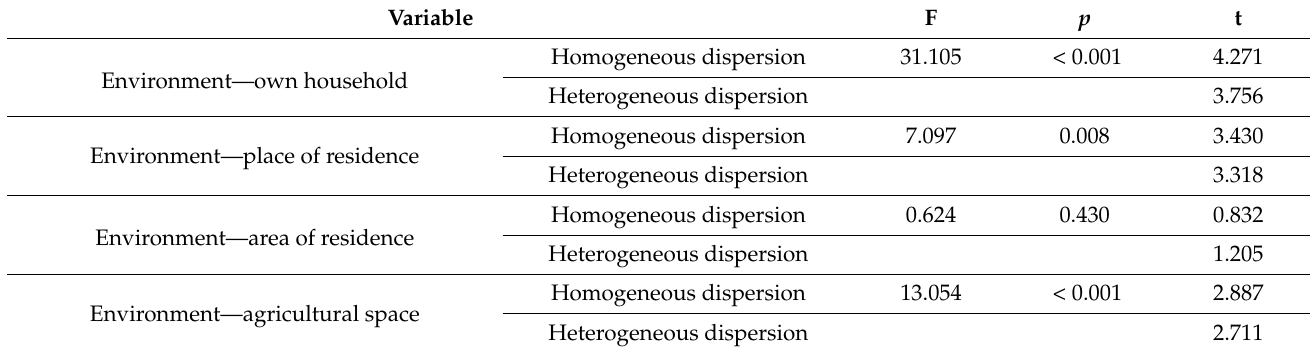
Table 3. Tests on meaning of the link between the nature representation and four factors defining the daily environment